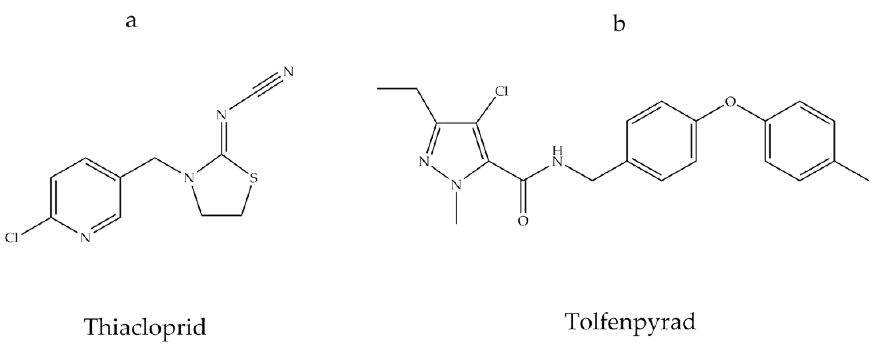
Figure 1. Chemical structures of ( a ) thiacloprid and ( b )